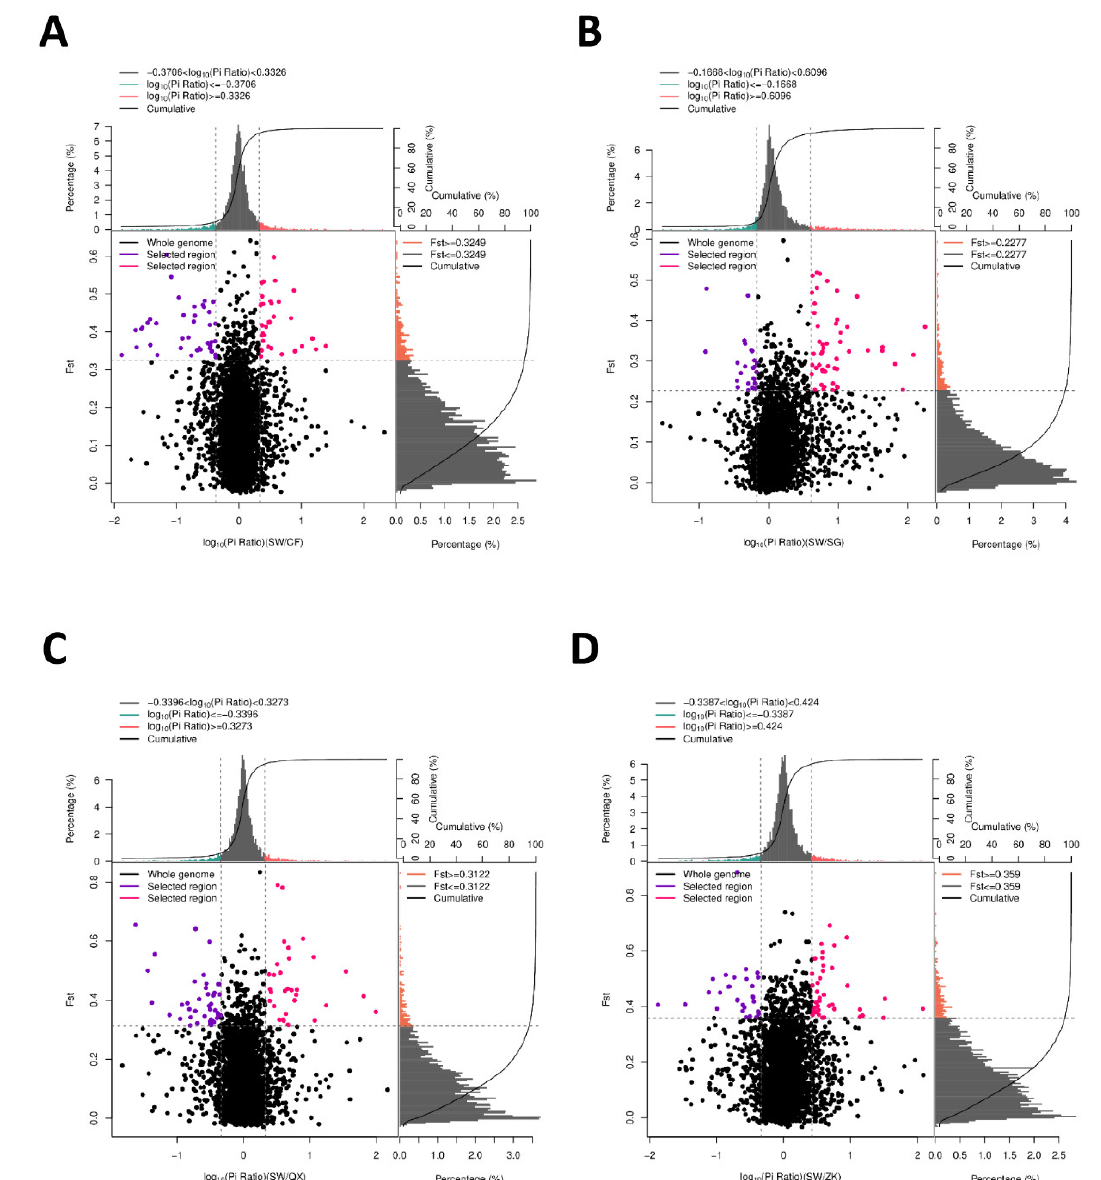
Figure 3. Selective elimination analysis of Fst and Pi between breeds. ( A ) The selective elimination analysis of Fst and Pi between SW and CF. ( B ) The selective elimination analysis of Fst and Pi between SW and SG. ( C ) The selective elimination analysis of Fst and Pi between SW and QX. ( D ) The selective elimination analysis of Fst and Pi between SW and ZK. The horizontal axis represents Pi ratio (Log10) value, the vertical axis represents Fst value, and the point plot in the middle represents the corresponding RATIO of Fst to Pi in different Windows. The top green and red region is the top 5% region selected by Pi, the right orange region is the top 5% region selected by Fst, and the middle red and purple region is the intersection of Fst and Pi, which is SNP loci in the selective eliminated